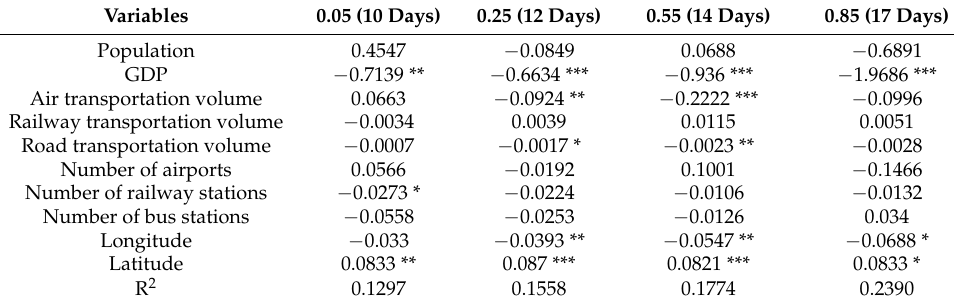
Table 6. Results of quantile